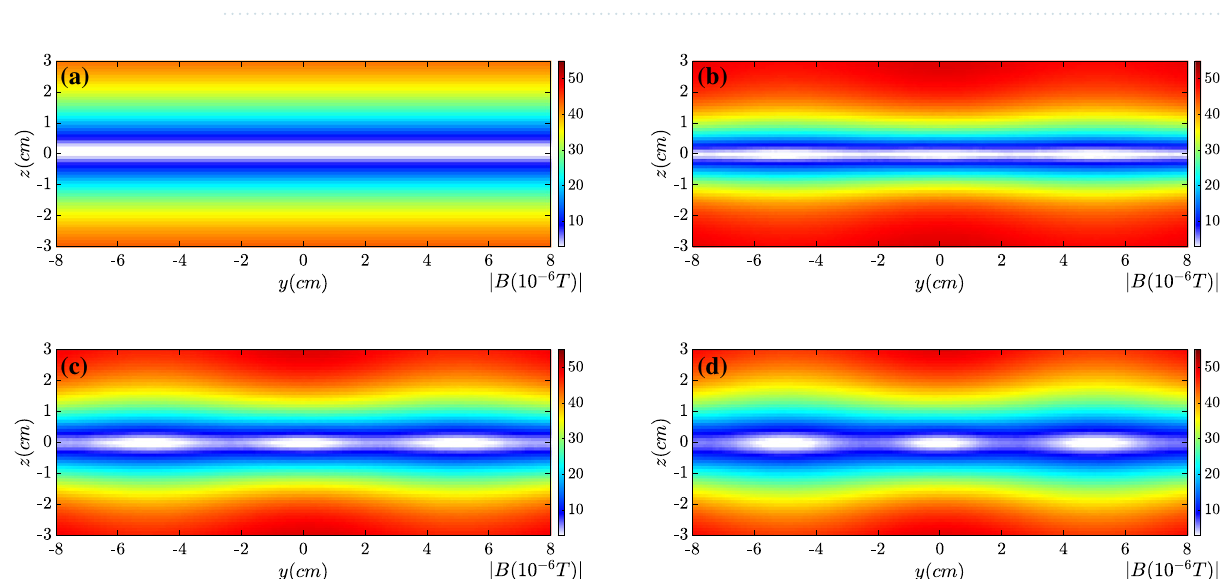
Figure 3. Distribution of magnetic field strength at x = 0 at ( a ) t = 0.0 , ( b ) t = 0.5 µ s , ( c ) t = 0.7 µ s and ( d ) t = 0.8 µ s . After t = 0.5 µ s magnetic reconnection becomes